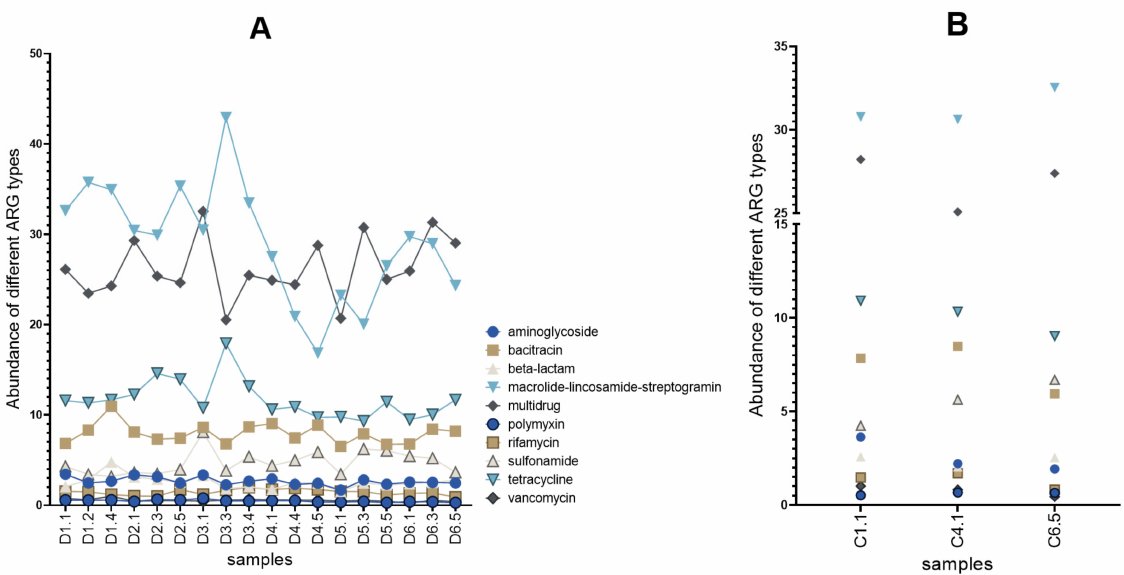
Figure 7. Abundance of ARGs [ppm] in process ( A ) and control bioreactors ( B ). The presented scale differs from that shown in Figure 3. D—dose ID, C—control samples.